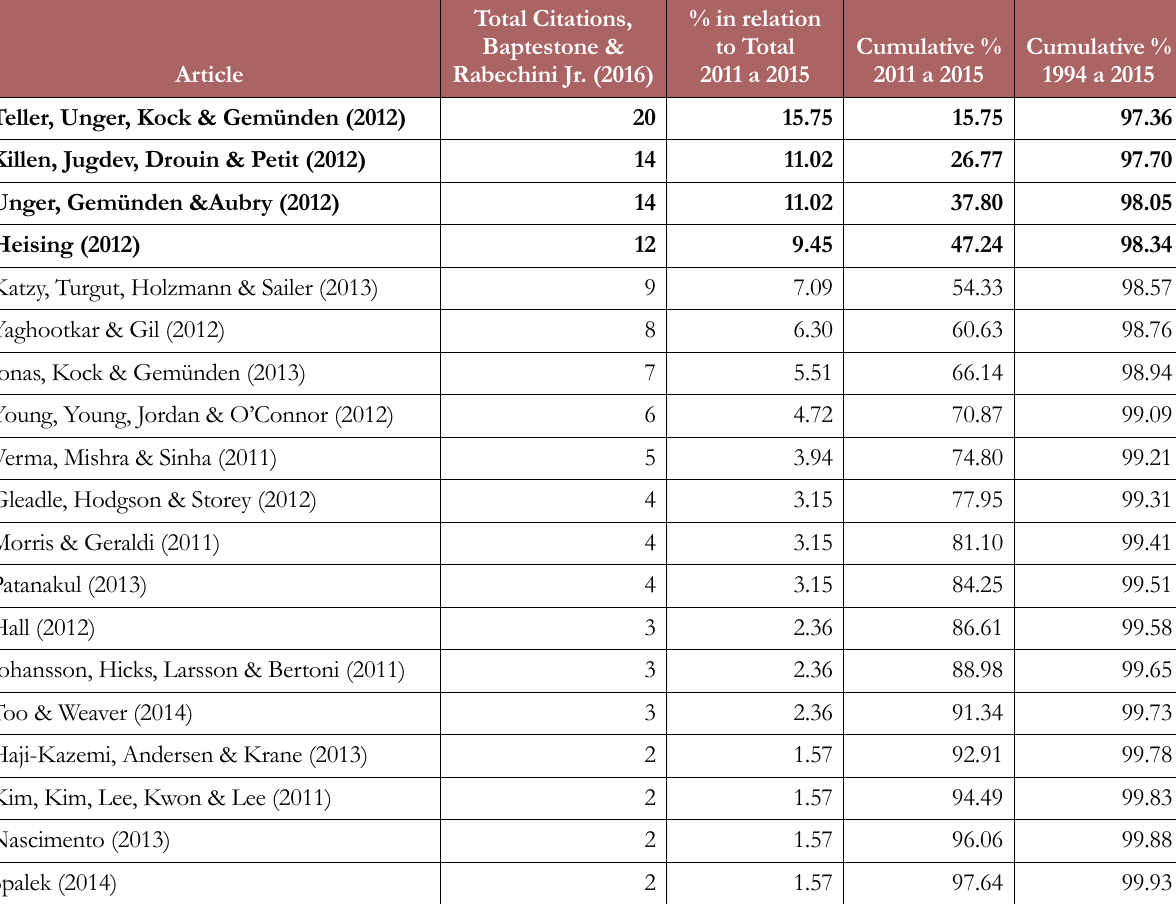
Total Citations, Baptestone &